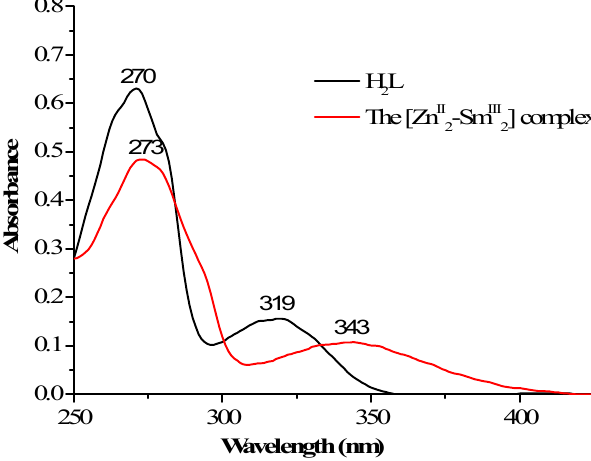
Figure 2. The UV–Vis spectra of H 2 L and the [Zn II2 –Sm III2 ] complex.